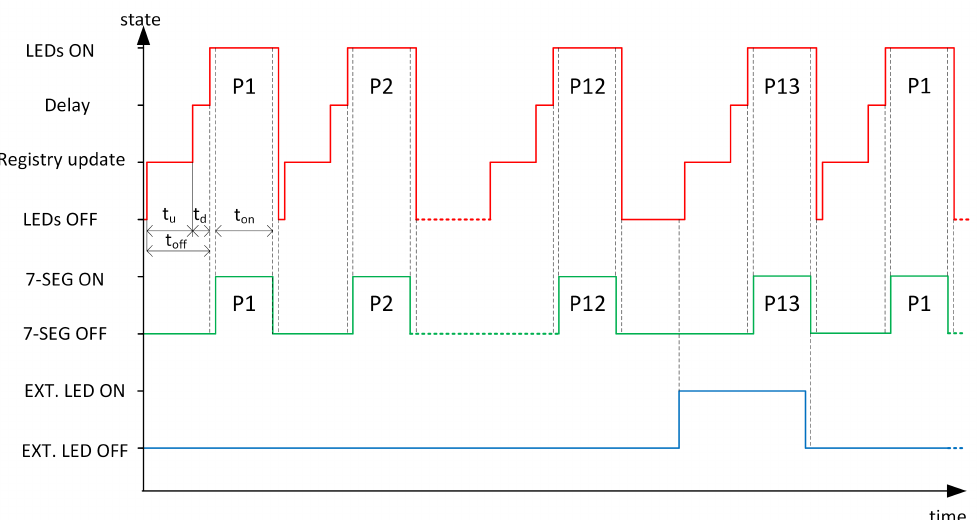
Figure 4. Timing diagrams utilized for control of NIR LEDs, external illumination LED, and the 7-segment